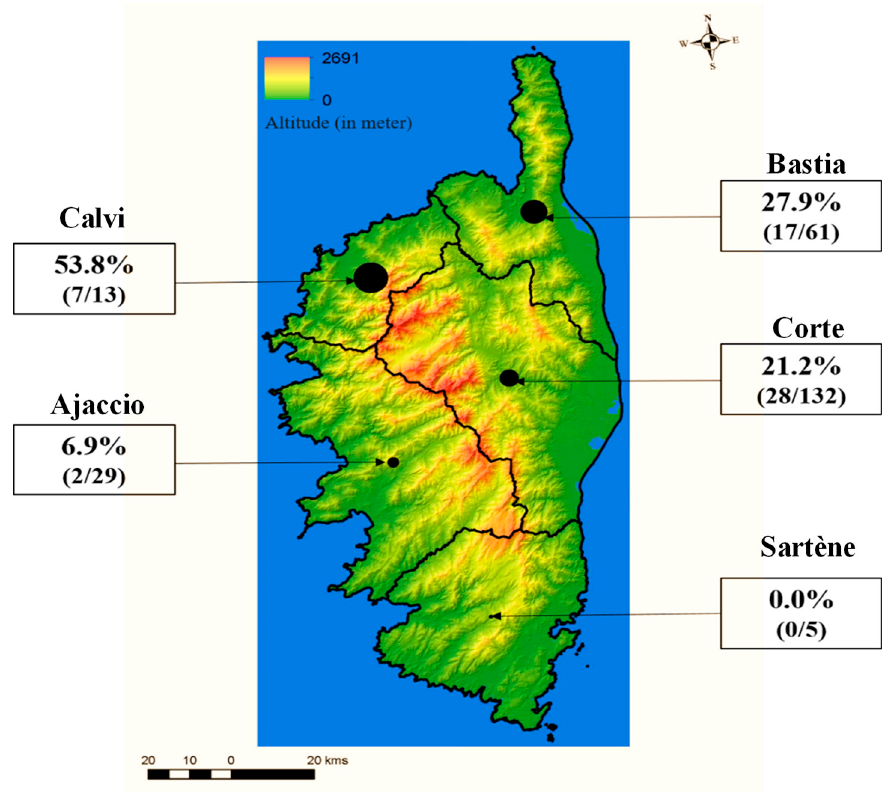
Figure 1. Distribution of Toscana virus (TOSV) seroprevalence among districts in Corsica. Table 2. Multivariate analysis of factors associated with Toscana virus seropositivity. Items OR (95%